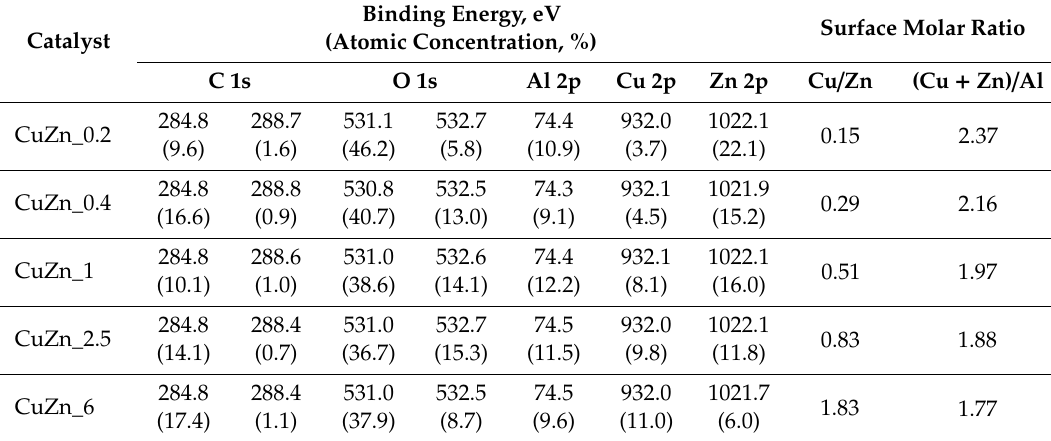
Table 4. XPS data of CuZn_X